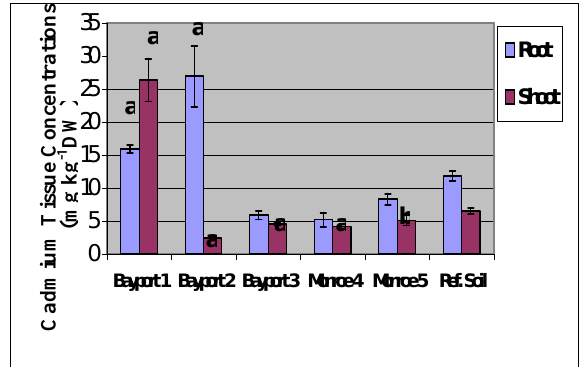
Figure 3: Mean concentrations of cadmium in Triticum aestivum (mean and standard error; N=4). a Statistically significant from the reference soil at the 5 percent significance level; b at the 10 percent significance level according to Dunnet test.